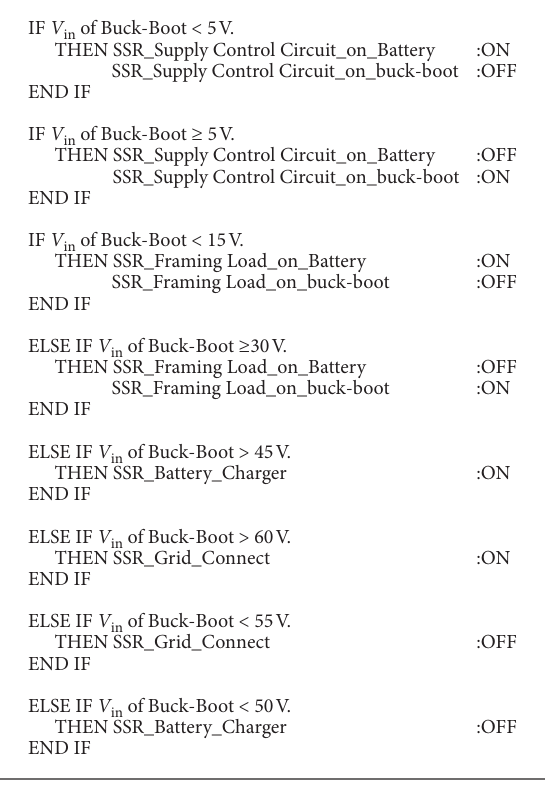
Figure 14: Pseudocode of the load conditions.